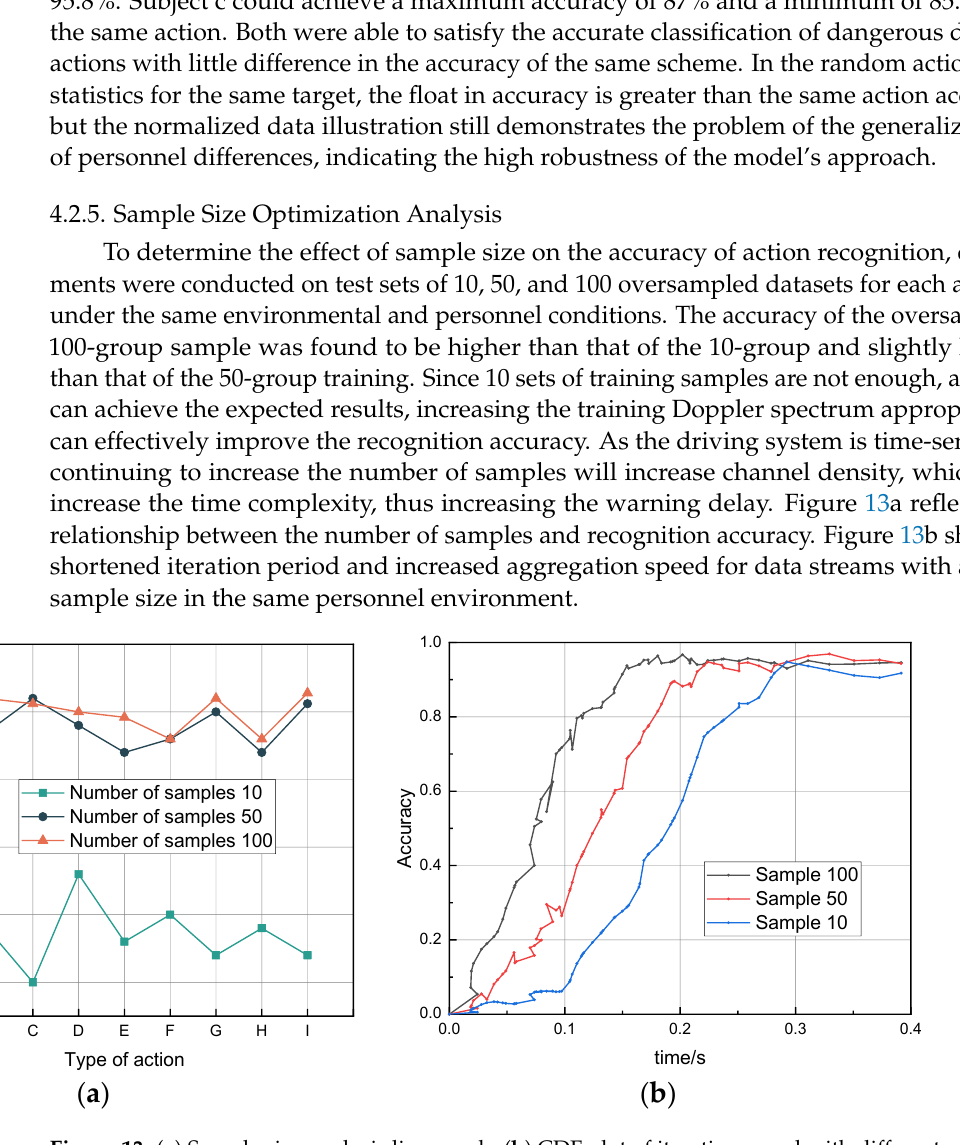
Figure 13. ( a ) Sample size analysis line graph. ( b ) CDF plot of iteration speed with different numbers of samples.